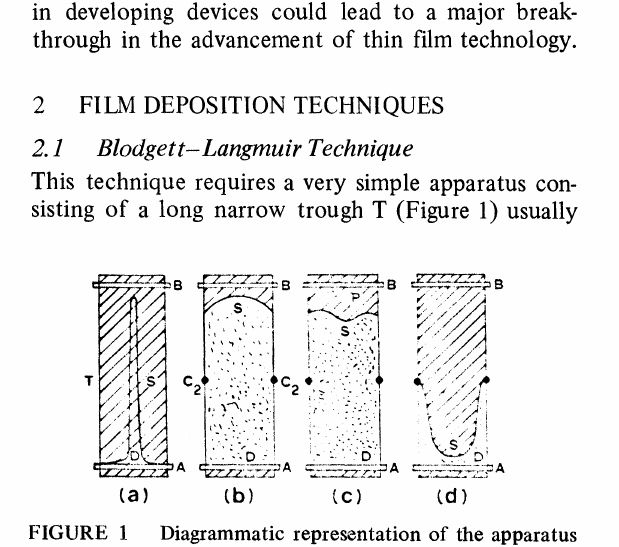
Diagrammatic representation of the apparatus for building up the Langmuir films [modified after Lang- muir